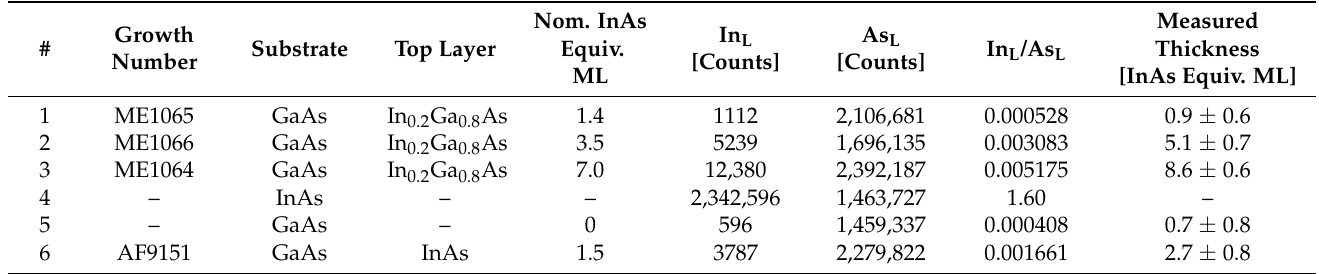
Table 3. List of specimens investigated and X-ray counts extracted for acquisition times of 1–1.15 h. Error bars are based on simple counting statistics for the background. The nominal InAs equivalent monolayers (ML) are the product of nominal layer thickness and nominal indium concentration of the group III sub-lattice, divided by half the relaxed unit cell thickness ( a /2) which corresponds to the thickness of a (002) lattice